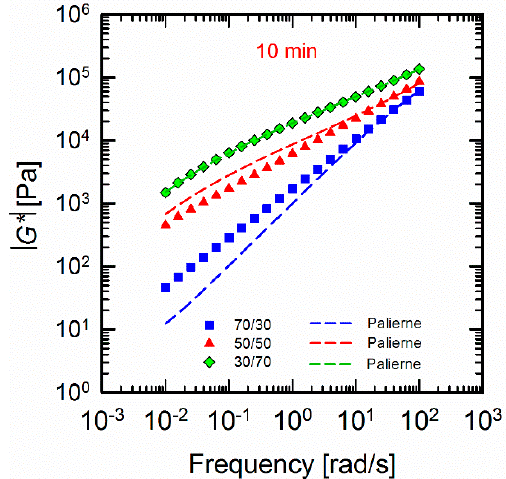
Figure 8. Palierne fittings of the 10 min processed (70/30), (50/50), and (30/70) PLA/PVDF blends measured at 200 °C. The dashed lines represent the fitted results. Table 1. The interfacial tension predicted by the Palierne model and the Gramespacher and Meissner model for the 10 min processed